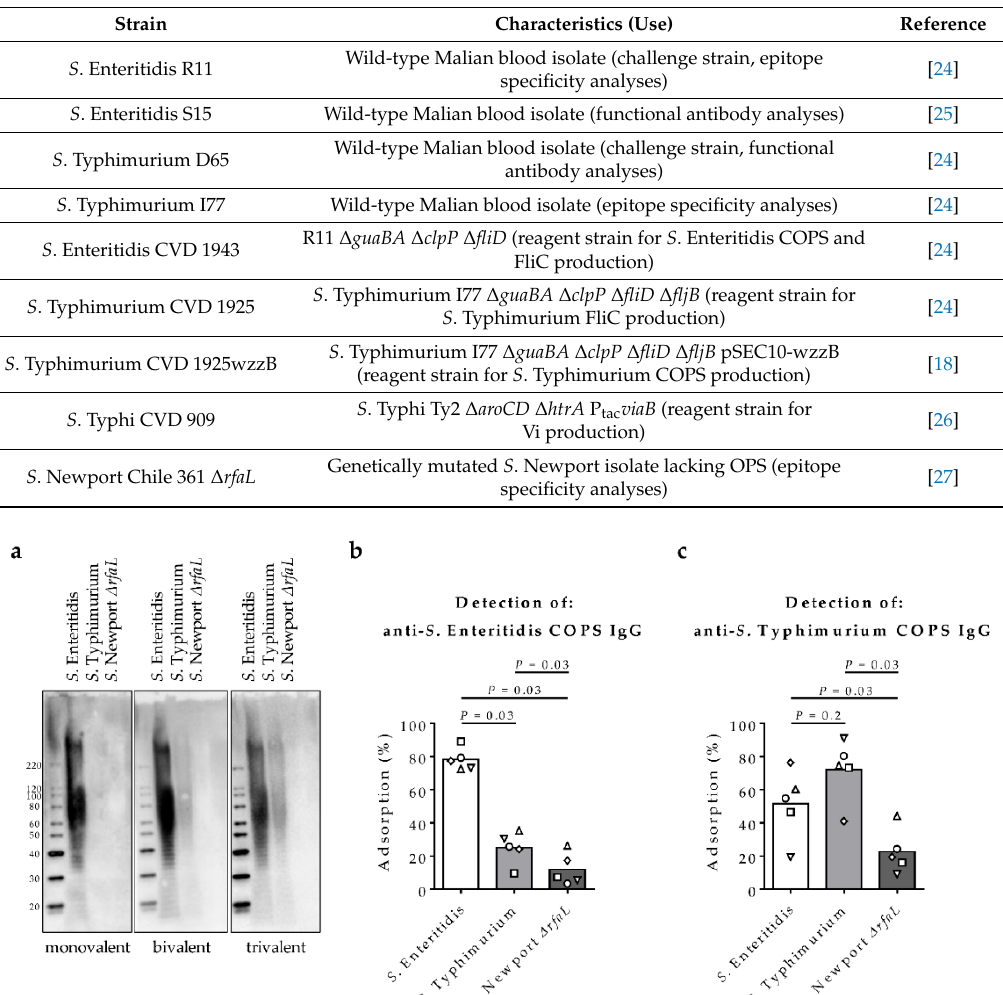
Table 1. Overview of Salmonella strains used in this study.